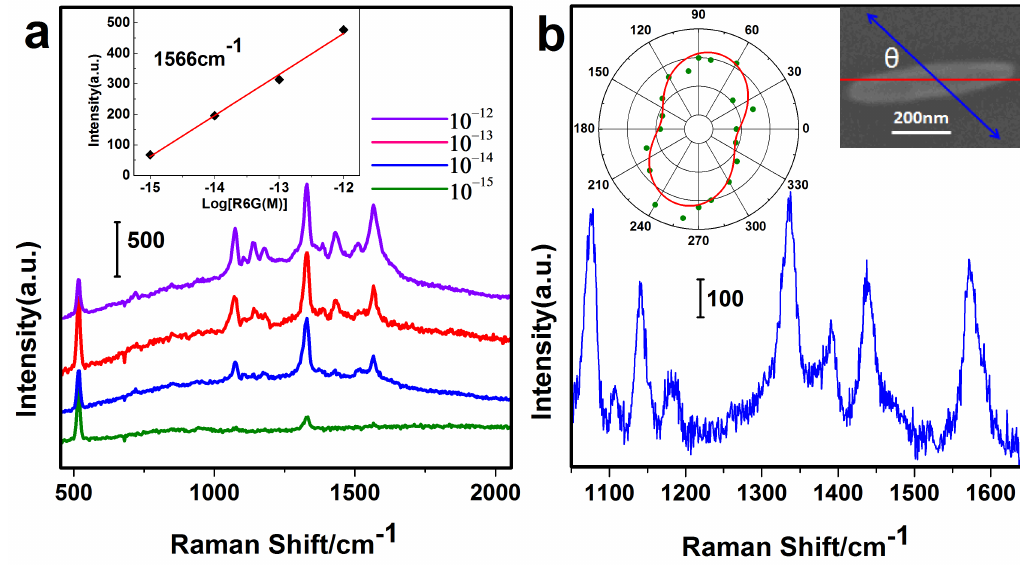
Figure 3. ( a ) Surface enhanced Raman scattering (SERS) spectra of R6G molecules with various concentrations. Inset: SERS intensity at 1566 cm − 1 as a function of R6G concentrations; ( b ) SERS spectra of p , p (cid:48) -dimercaptoazobenzene (DMAB) is collected at a single particle. Inset: Polar plot of the Raman intensity (solid green circles) versus the excitation polarization direction, the red curve is a fit to the cosine squared function (left) and the corresponding SEM image (right, θ represents the angle between polarization and